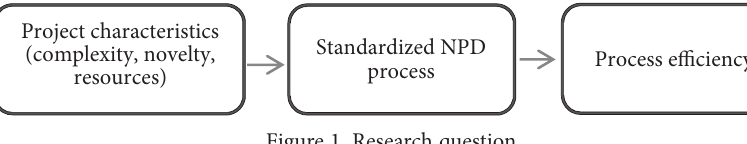
Figure 1. Research question